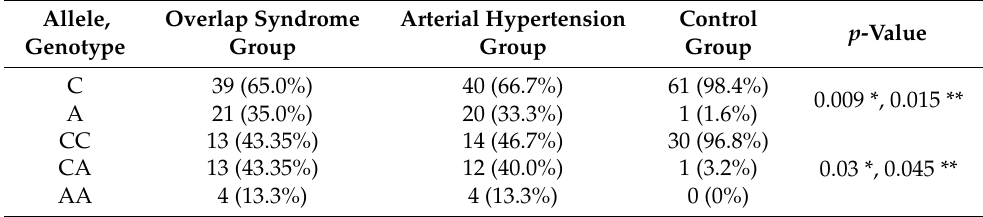
Table 1. Allele frequencies and genotype distribution of rs2779249 of the NOS2 gene. Allele, Overlap Syndrome Genotype Group